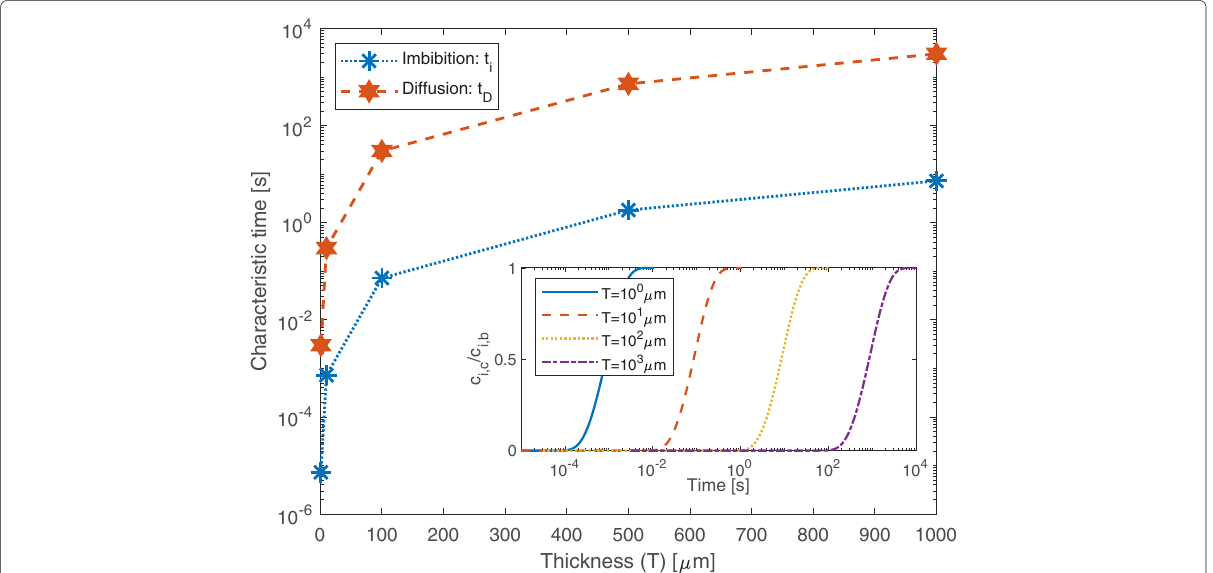
Fig. 4 Characteristic filling times of the nanopores. Characteristic times of the nanopore filling by capillarity (blue dotted line, t i ) and particle diffusion (red dashed line, t D ) varying the thickness of the nanoporous silica tablet (nanopores with 11.04-nm diameter; solution of 1AKI proteins in water at 1% weight fraction). The particle diffusion process through the fully hydrated pores requires a characteristic time t D two orders of magnitude higher than t i , in all the analyzed configurations. The inset shows the ratio between the particle concentration at the center of the nanopore ( c i , c , at x = T / 2) and the bulk one ( c i , b , at x = 0 and T ) as a function of time for different thickness ( T ) of the